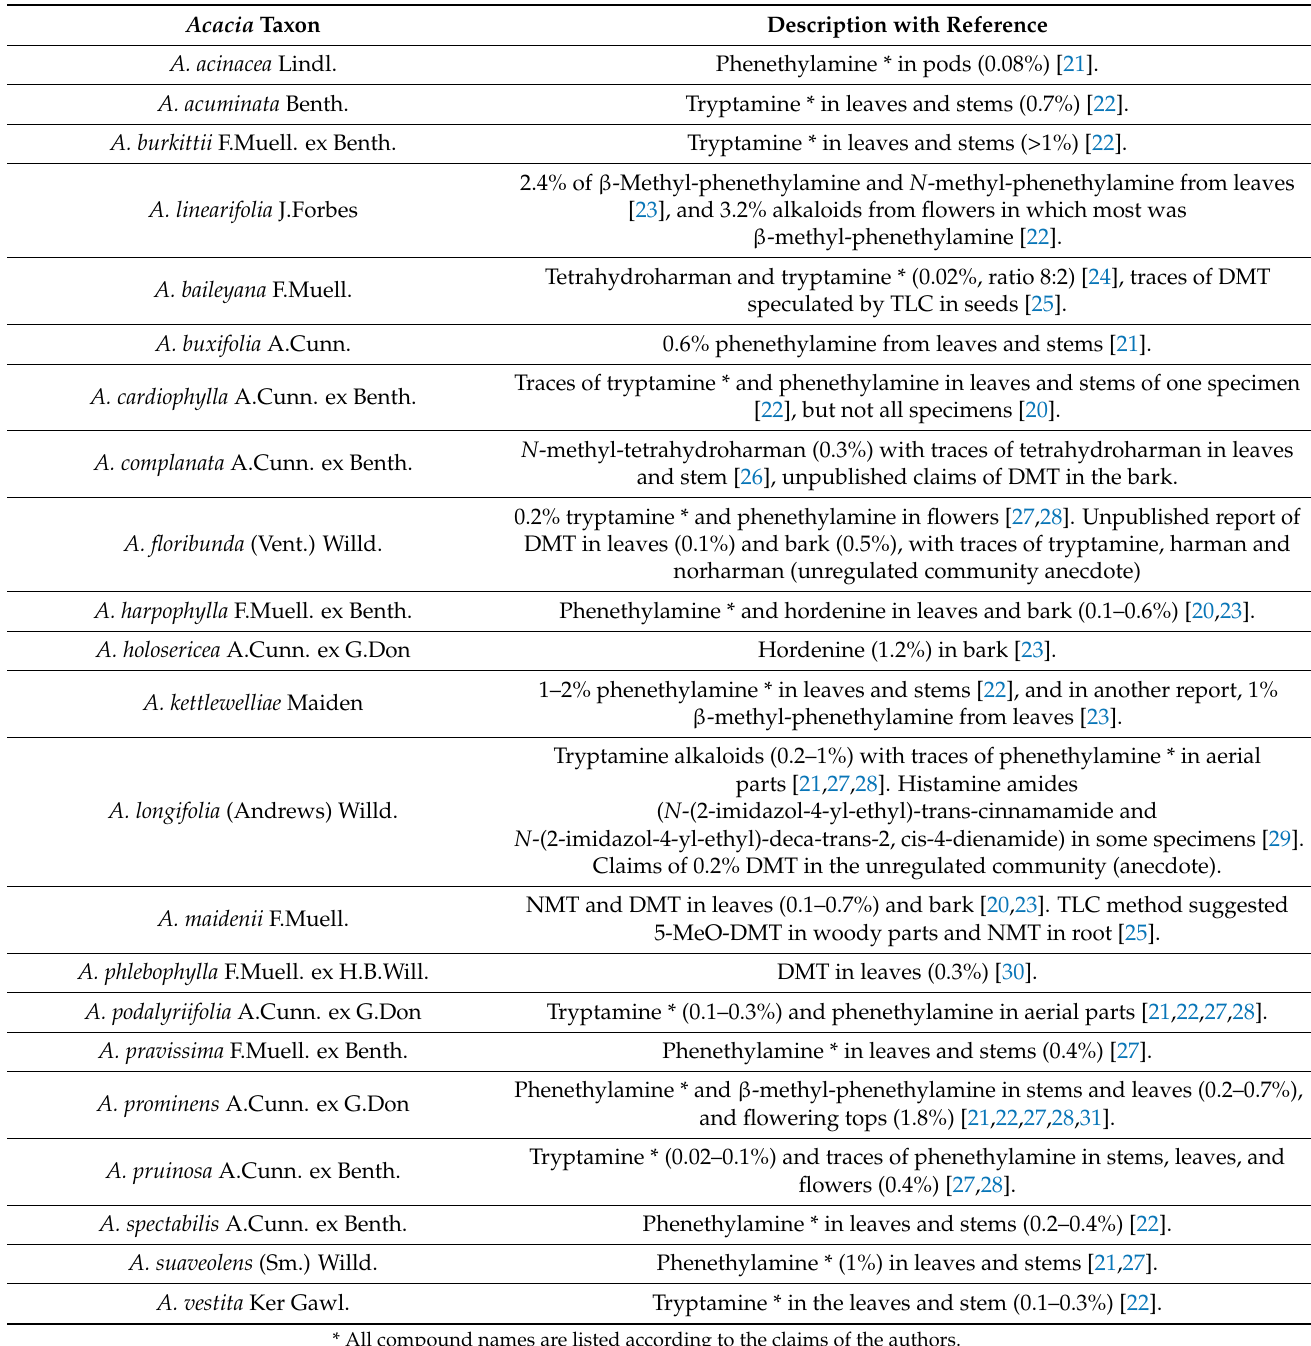
Table 1. Australian species of Acacia with verified records of psychotropic alkaloids. Acacia